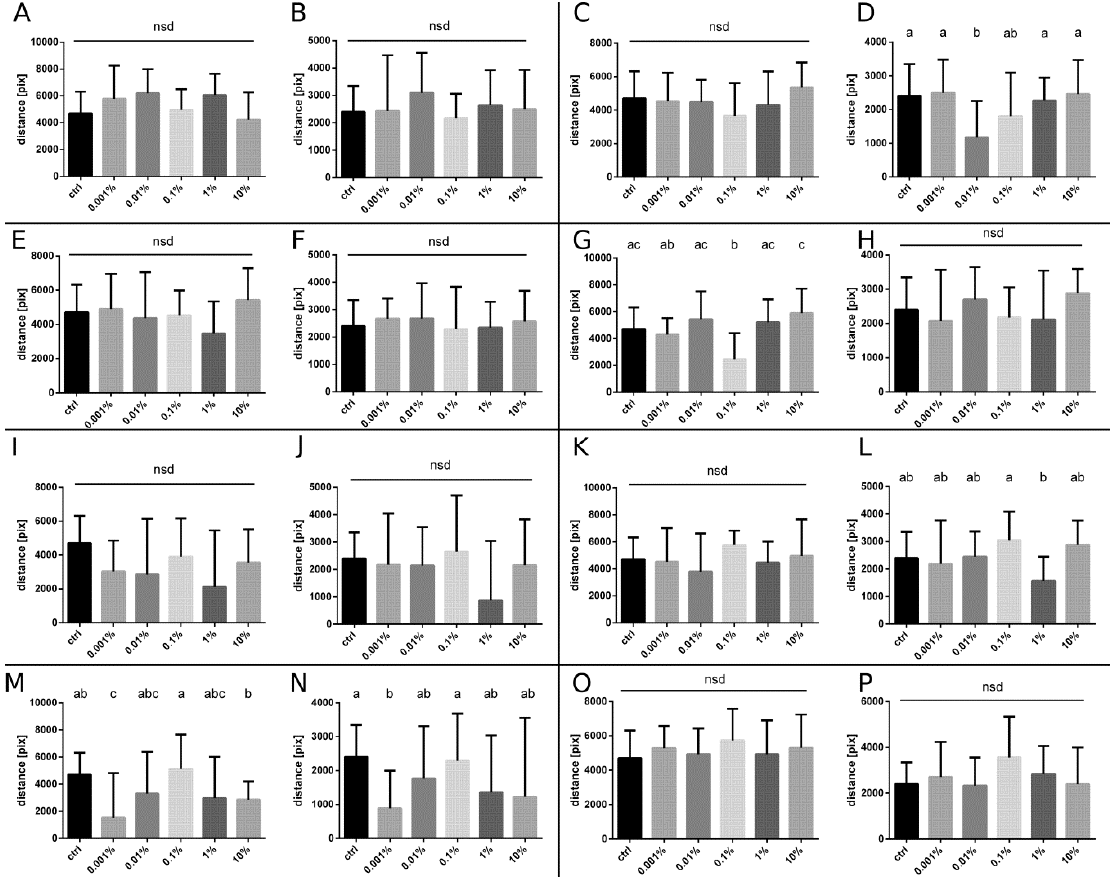
Figure 3. Distance (px) reached for insects treated with a single essential oil or a mixture (1:1 or 1:1:1) of essential oils in different concentrations and the control. Median and quartiles are presented, Kruskal-Wallis test p < 0.05. Different letters indicate statistically different groups. Different letters indicate statistically different groups. Citronella EO (A) - interval 1, (B) - interval 2; lemon EO (C) - interval 1, (D) - interval 2; mint EO (E) - interval 1, (F) - interval 2; vanilla EO (G) - interval 1, (H) - interval 2; 1:1 mix of citronella and lemon EOs (I) - interval 1, (J) - interval 2; 1:1 mix of citronella and vanilla EOs (K) - interval 1, (L) - interval 2; 1:1 mix of vanilla and lemon EOs (M) - interval 1, (N) - interval 2; 1:1:1 mix of vanilla, citronella and lemon EOs (O) - interval 1, (P) - interval 2.